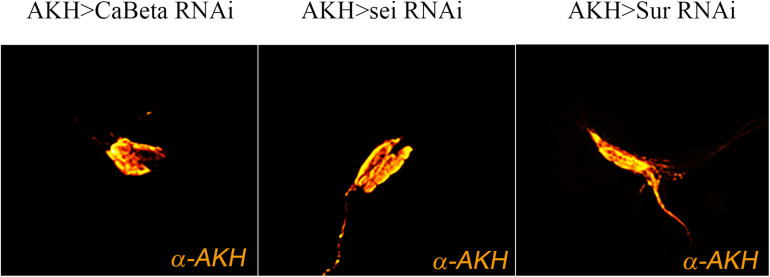
Expression of ion channel RNAi elements do not change AKH cell viability. Expression of ion channel RNAi’s does not impair cell viability or AKH synthesis. Representative images of adult AKH cells expressing Ca-Beta-RNAi (left), sei-RNAi (middle), and Sur-RNAi (right) counterstained with α-AKH.